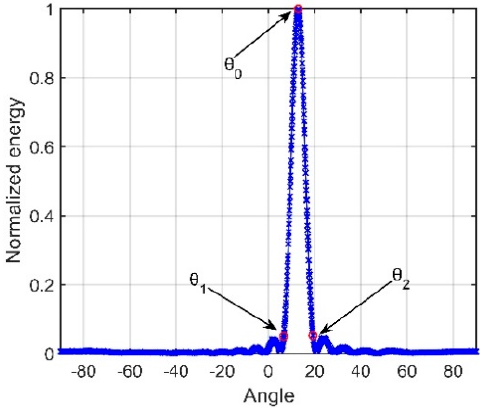
Figure 5. Beam output of the vertical line array.